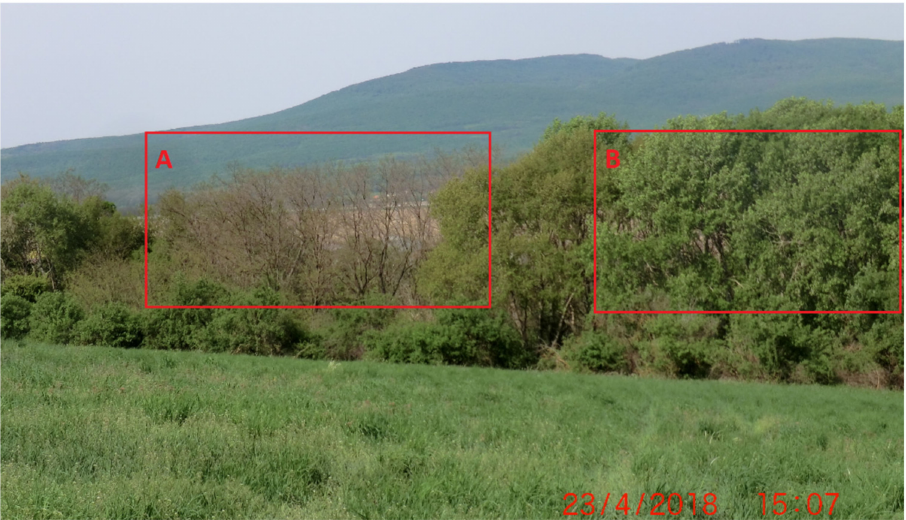
Figure 2. ( A ) Black locust in SWF without leaves; ( B ) Native vegetation in SWF with